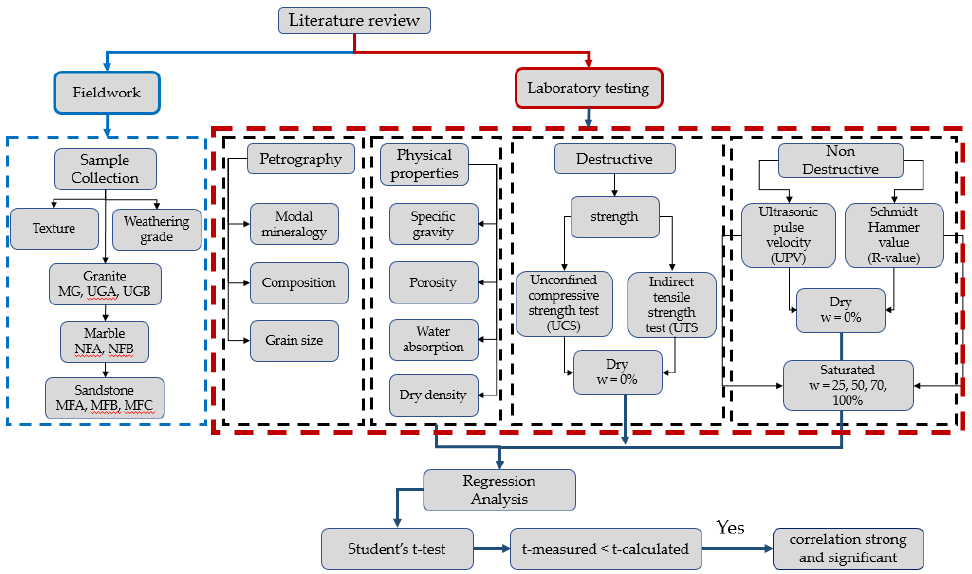
Figure 2. Flow chart of the research methodology.